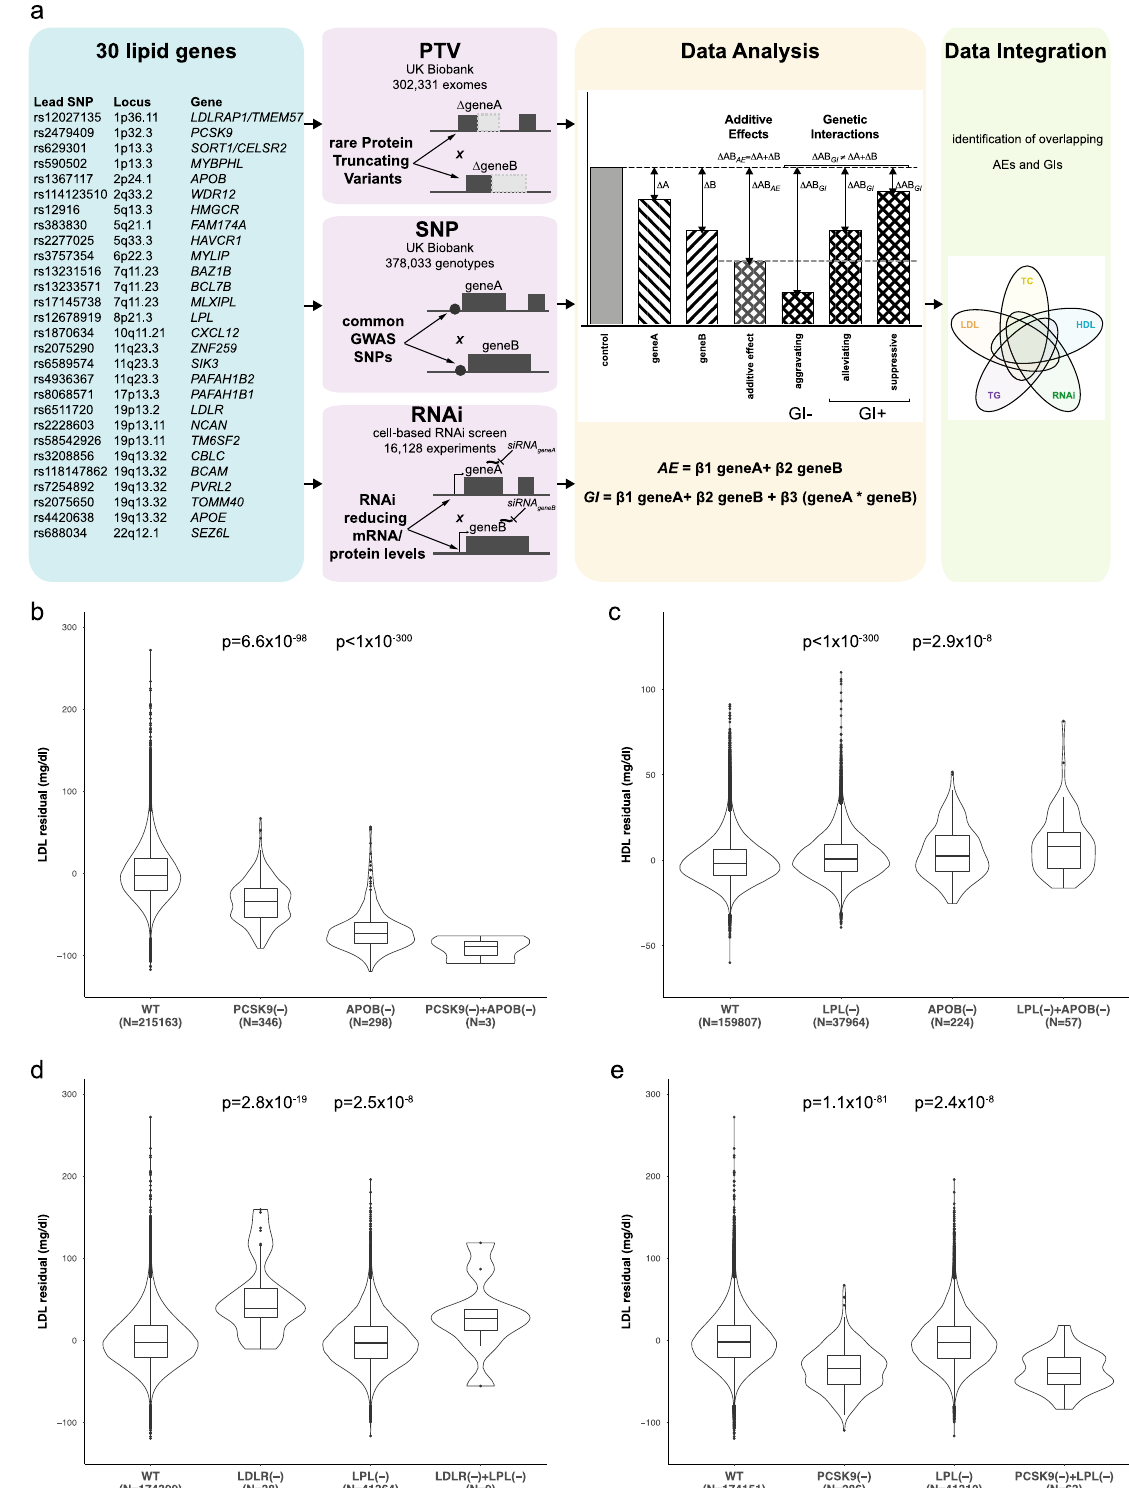
function of both genes modulates the respective lipid measures (Fig. 1b – e, Supplementary Data 5). For instance, while control individuals without PTVs in either PCSK9 or APOB had average levels of 138.3 mg/dl LDLc, PTVs in PCSK9 and APOB individually reduced mean plasma LDLc by 34.5 mg/dl